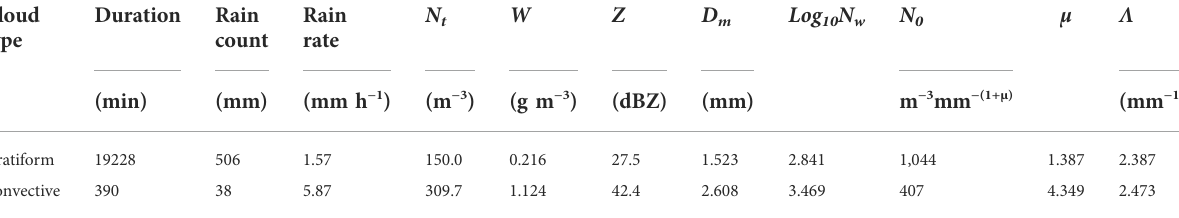
TABLE 3 Integral rain parameters obtained from the average raindrop size distribution for the stratiform and convective precipitation types.